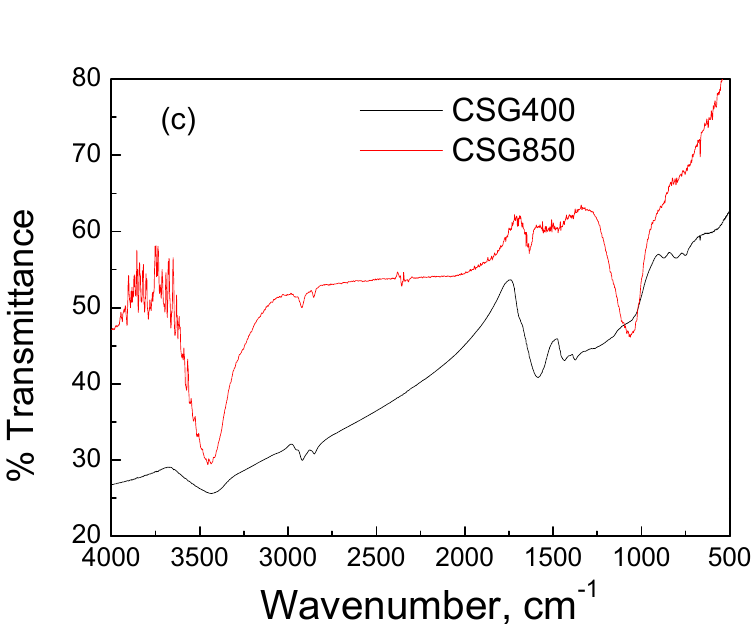
Figure 3. FTIR spectra of the prepared biochars: ( a ) OK400 and OK850, ( b ) MSR400 and MSR850, ( c ) CSG400 and CSG850.